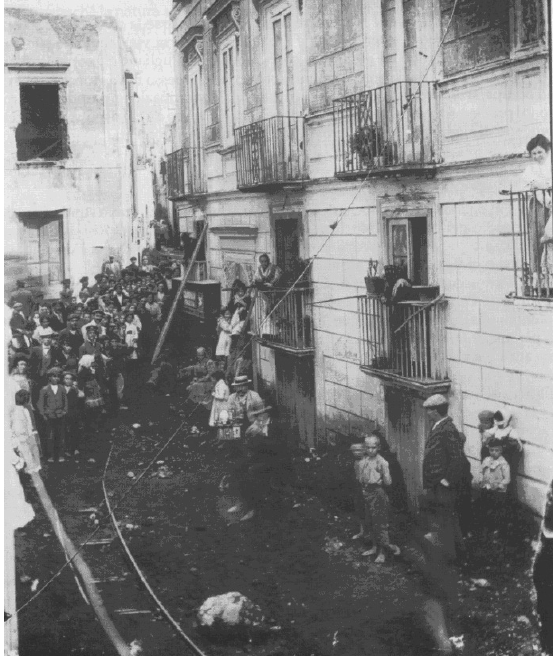
Figure 9. Flood event occurred in Ercolano, September 21, 1911 (from Gaudio